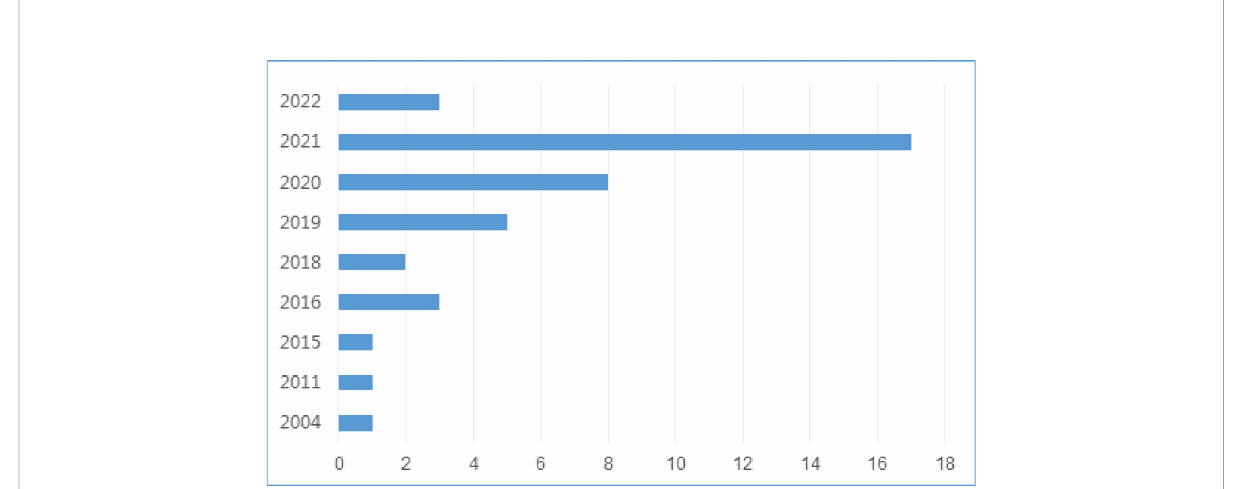
FIGURE 2 Distribution of studies by the year of publication.